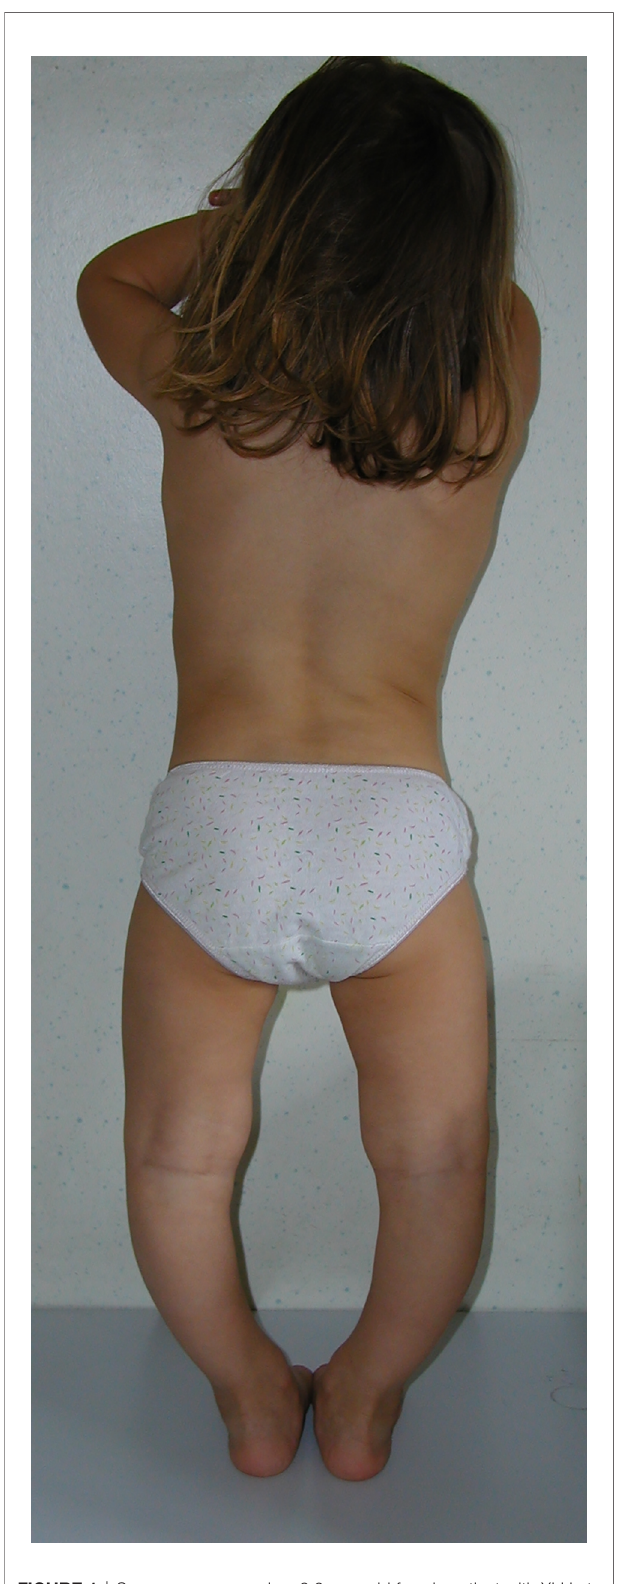
FIGURE 1 | Severe genu-varum in a 3.2-year-old female patient with XLH at diagnosis with disproportionate short